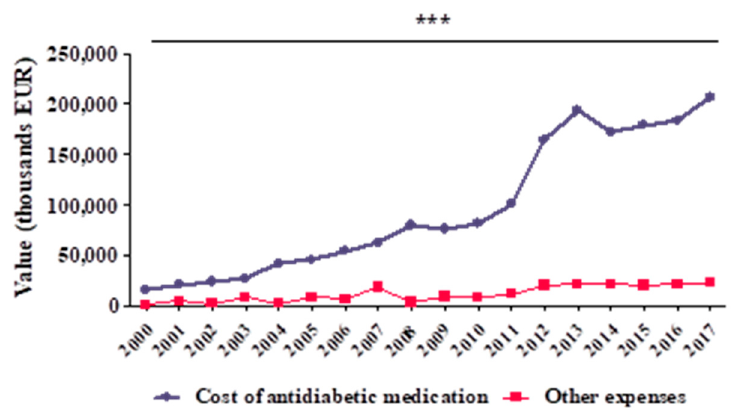
Figure 3. Structure of diabetes DMF during 2000–2017 (thousand EUR): cost of antidiabetic medication (OADs and insulins) and other expenses (HbA1c assessment, Self-monitoring blood glucose (SMBG) test, insulin pumps and supplies for insulin pumps) (r = 0.945, *** p < 0.001).